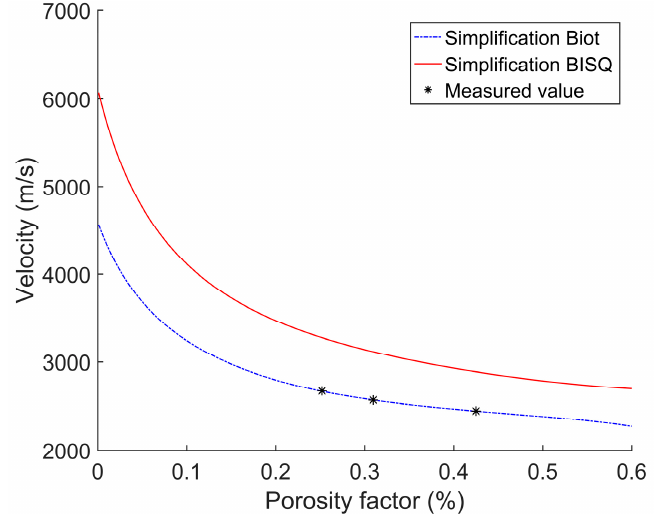
Table 3. Measurement results of sound velocity and attenuation of CRC similarity model.